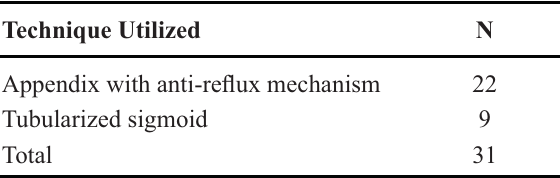
Table 2 – Patients with serious fecal incontinence according to the surgical technique